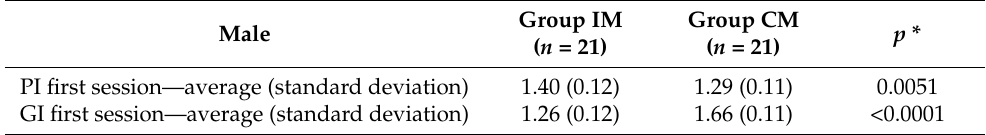
Table 7. Average (standard deviation) of PI and GI in the first monitoring session in male patients.